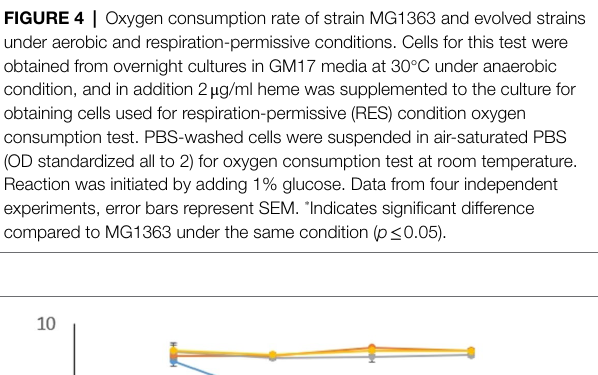
FIGURE 6 | Acidification capacity of MG1363 and evolved strains. Test started with cells at OD = 0.1 in GM17 media, incubated statically at 30 °